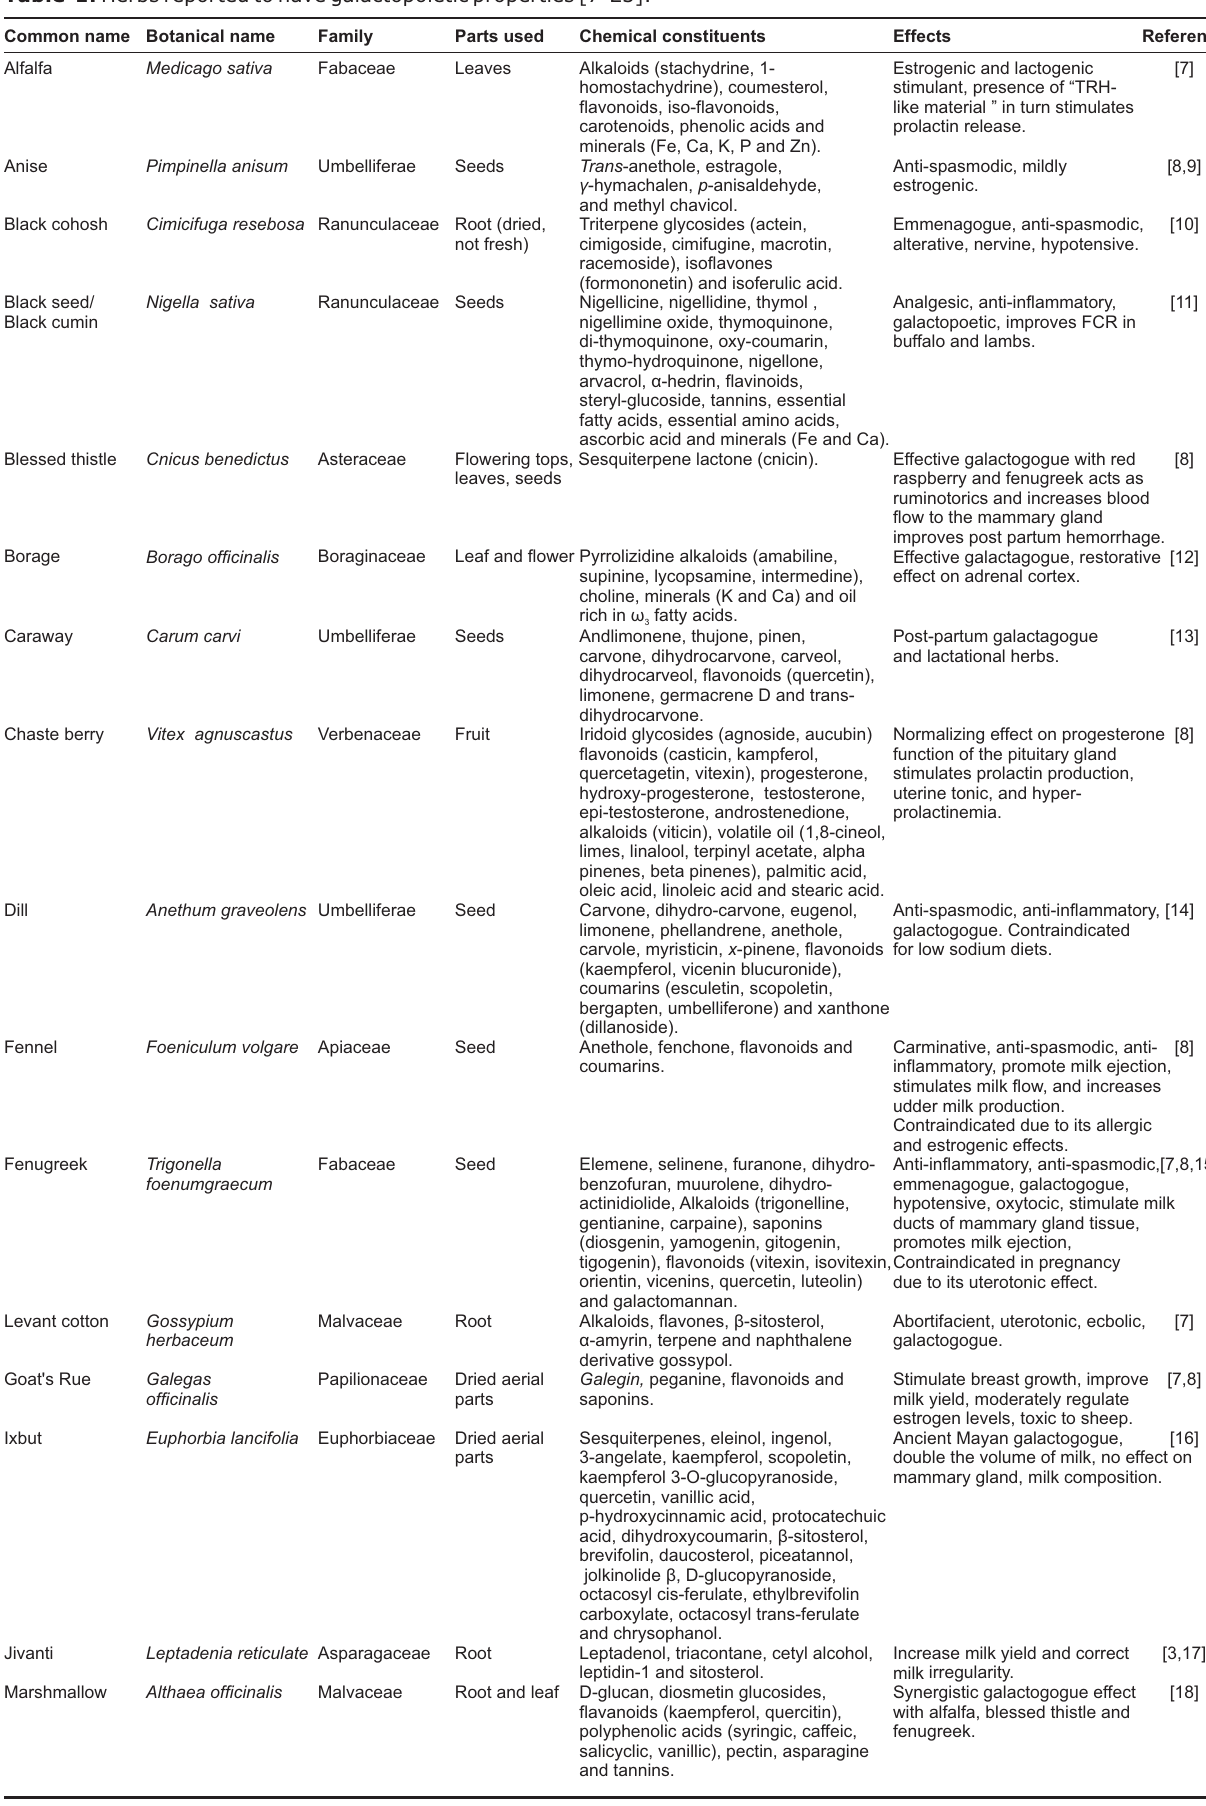
Table-1: Herbs reported to have galactopoietic properties